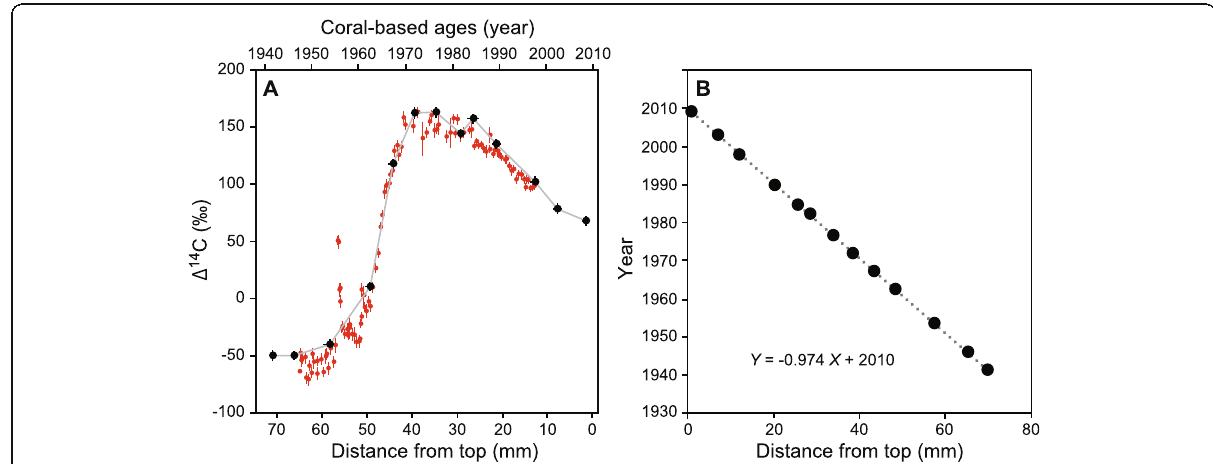
Fig. 5 A Comparison of the depth domain profile of radiocarbon ( Δ 14 C) data of the SMJ-2-S1 sclerosponge with a coral-derived time series from Ishigaki Island in the southern part of Ryukyu Islands (Hirabayashi et al. 2017). B Established age model in this study at the assumption